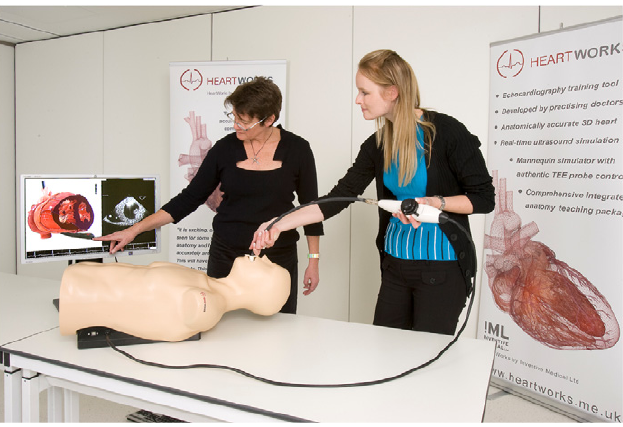
Figure.9 TOEsimulatorinuse.Thesoftwarehasbeenconfiguredtodisplaythestudent’spositioningoftheTOE transducer and ultrasound plane relative to the heart, alongside the simulated ultrasound image. The 3D heart model has been sliced in the plane of the